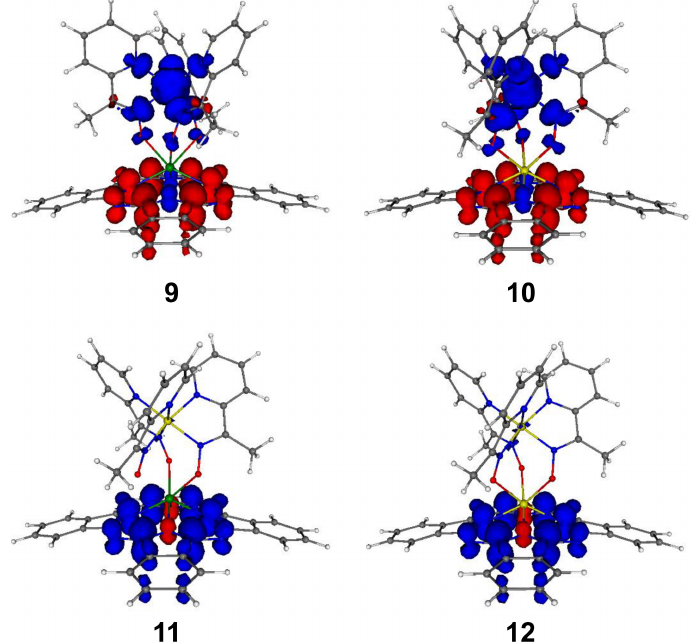
Figure 5. B3LYP/LanL2DZ-calculated spin density distributions in the 1e-reduced forms of the complexes 9 – 12 . The isovalue is set to ±